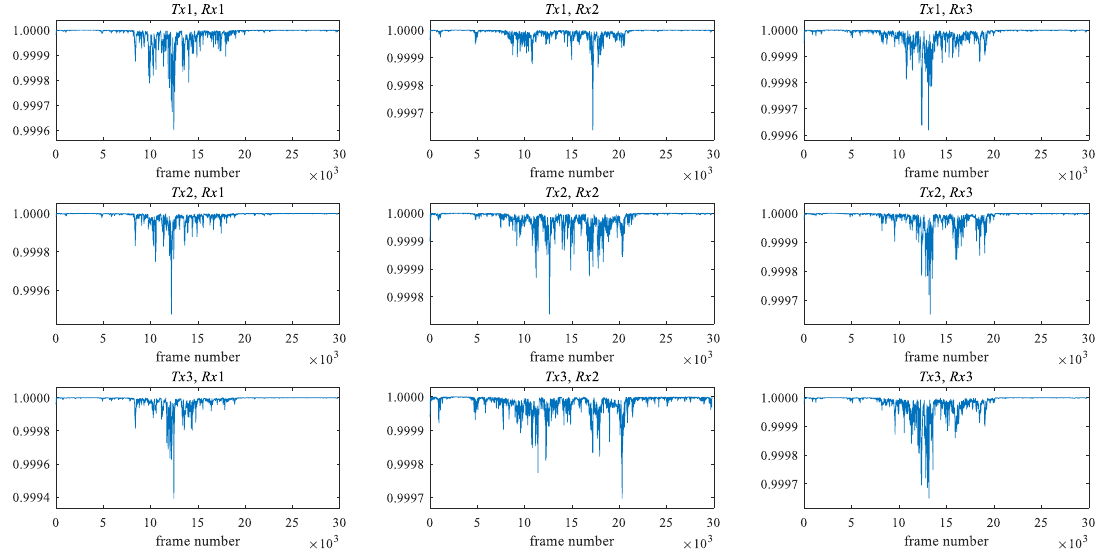
Figure 4. The maximum eigenvalue characteristics of CSI amplitude when the low pass filter is applied.